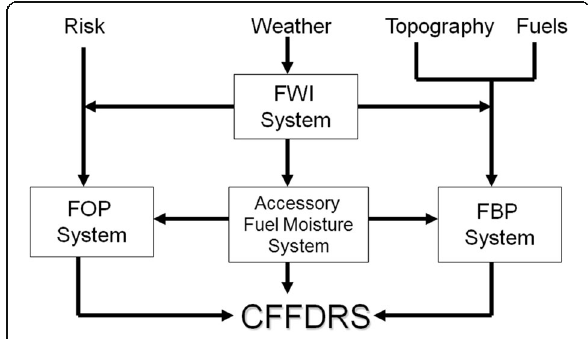
Fig. 1 The Canadian Forest Fire Danger Rating System flow chart (FCFDG 1992)